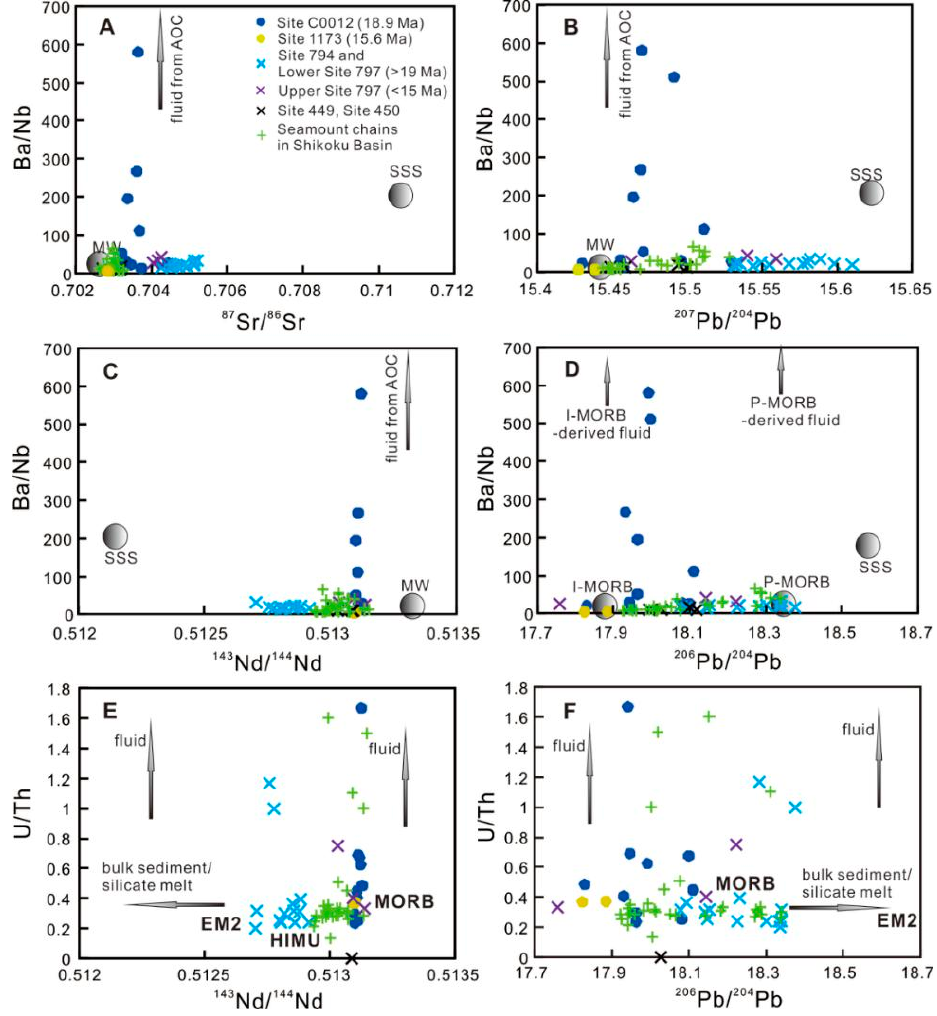
Figure 18. The plots of Ba/Nb versus 87 Sr/ 86 Sr ( A ), Ba/Nb versus 207 Pb/ 204 Pb ( B ), Ba/Nb versus 143 Nd/ 144 Nd ( C ), Ba/Nb versus 206 Pb/ 204 Pb ( D ), U/Th versus 143 Nd/ 144 Nd ( E ), U/Th versus 206 Pb/ 204 Pb ( F ) for Site C0012, 1173 volcanic rocks from the Shikoku Basin. Data sources as for Figure 10. The fields of mantle wedge (MW), subducted slab sediments (SSS), Indian Ocean MORB (I-MORB), Pacific MORB (P-MORB), fluid from altered oceanic crust (AOC) are cited from Reference [90].